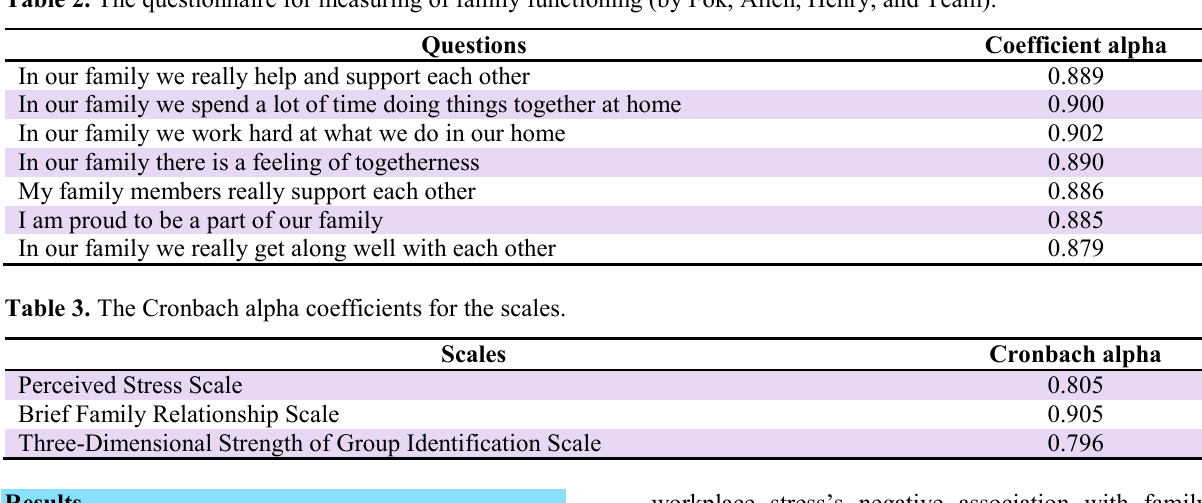
Table 2. The questionnaire for measuring of family functioning (by Fok, Allen, Henry, and Team).